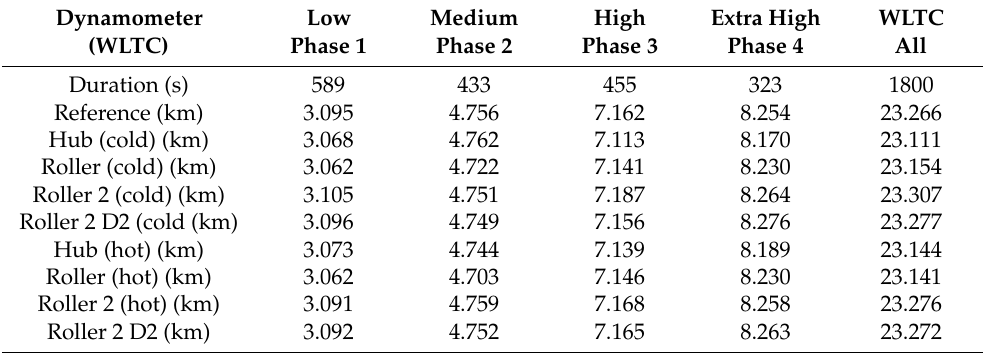
Table 2. Comparison of distances reported from the roller- and hub-type dynamometers for the cold- and hot-start WLTCs. D2 = second